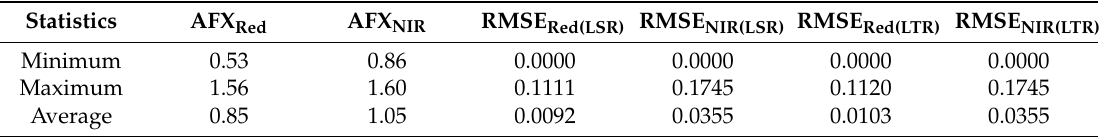
Table 3. The AFX and fit-RMSE statistics between the RTCLSR/RTCLTR and PROSAIL models for diverse